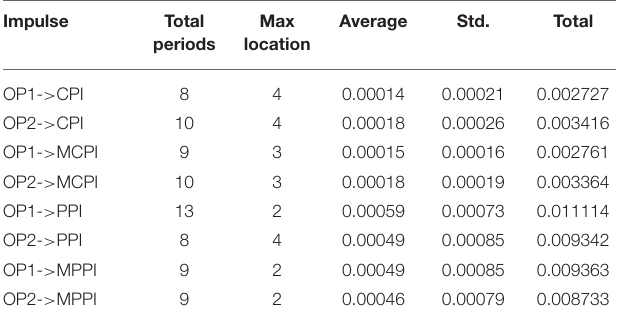
TABLE 3 | Statistical description of accumulated response according to monetary